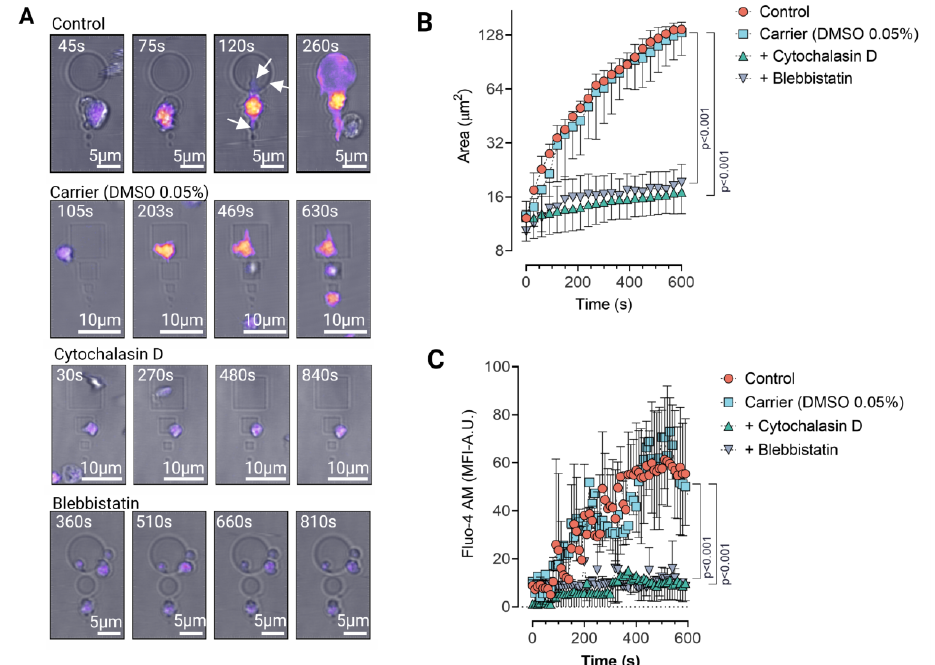
Figure 2. Platelets use filopodia as antennae to seek out and adhere to Agg-IgG on micropatterns through Fc γ RIIA and exhibit haptotaxis along laterally increasing Agg-IgG density on 2D planar micropatterns. ( A ) Platelets preloaded with Ca 2+ indicator dye Fluo-AM were incubated on micropatterns functionalized with Agg-IgG were imaged by time-lapse video microscopy. Representative time-lapse images of Ca 2+ release and platelet morphodynamics during adhesion and spreading on Agg-IgG micropatterns with a pitch distance of 1 µ m show platelet filopodia actively scan their surrounding microenvironment as platelets adhere, spread in a polarized manner resembling haptotaxis, and become activated on Agg-IgG micropatterns. This process is abrogated upon pretreatment of platelets with F-actin polymerization inhibitor cytochalasin D (25 µ M) and myosin II ATPase inhibitor blebbistatin (10 µ M) (see Supplementary Videos S1–S4); ( B ) Analysis of platelet morphodynamics (shape changes over time) and ( C ) changes in calcium binding dye Fluo-4 AM fluorescence (mean fluorescence intensity- MFI) during intracellular calcium release from time-lapse video microscopy reveals platelets undergo minimal morphodynamics upon pretreatment with F-actin polymerization inhibitor cytochalasin D (25 µ M) and myosin II ATPase inhibitor blebbistatin (10 µ M), indicating Agg-IgG sensing by platelets through their Fc γ RIIA is dependent on the stability of the